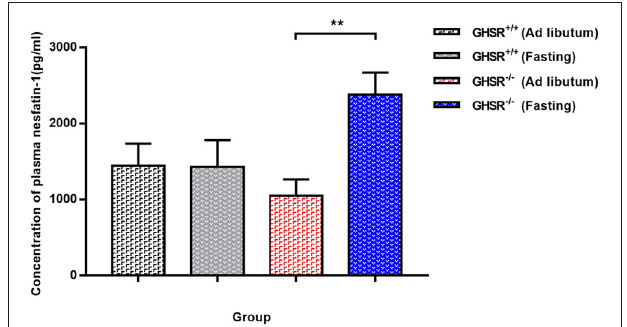
FIGURE 2 | Circulating Nesfatin-1 in GHSR + / + and GHSR − / − Mice. GHSR + / + and GHSR − / − mice were fasted for 12h or fed ad libitum . We obtained blood samples from the end of the tail, after which we performed ELISA. Data are expressed as mean ± SEM ( n = 6–7/group). ** P < 0.01 for the effect of GHSR − / − mice in fasting condition vs. GHSR − / − mice in ad libitum . GHSR − / − mice in fasting condition vs. GHSR + / + mice in